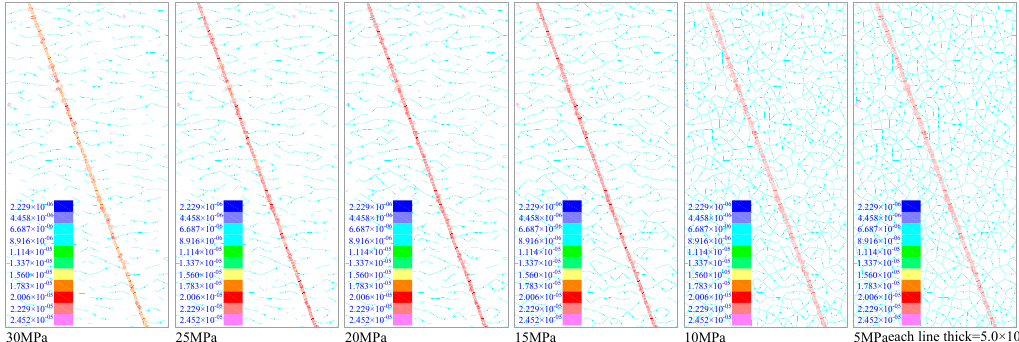
Figure 15. Joint hydraulic aperture values.